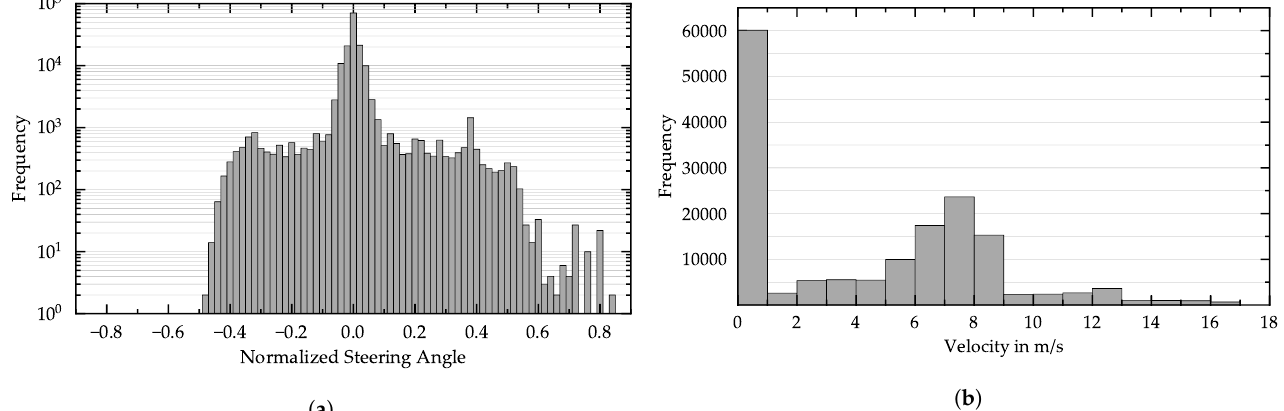
Figure 5. Distribution of the captured dataset for ( a ) the steering angle and ( b ) the velocity. The dataset contains 160,000 sam- ples in